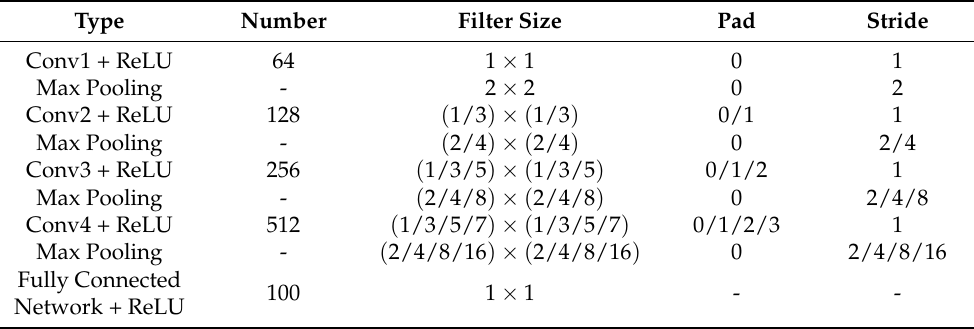
Table 5. Structure parameters of the mmsCNN.